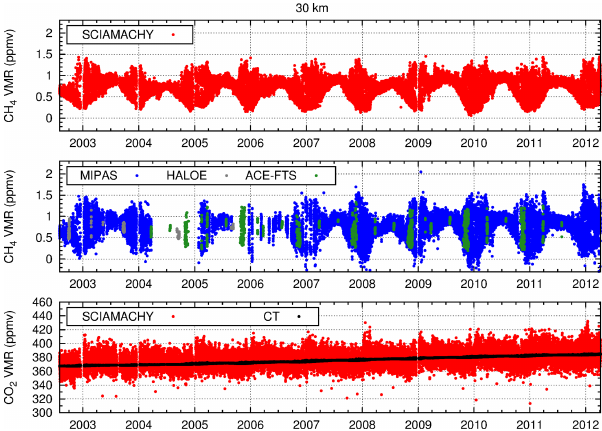
Figure 6. Example for resulting VMR profiles for CH 4 (left) and CO 2 (right). Red shows the results for the current product version (V4.5.2). For comparison, the CH 4 profile from the previous prod- uct version (V3.3.6) is also shown in the left plot in blue. Green (left) indicates collocated CH 4 profiles from ACE-FTS V3.5. Black (right) indicates the CO 2 profile from CarbonTracker (CT2013). Er- ror bars denote the errors given in the products. No error is given for the CarbonTracker model data.